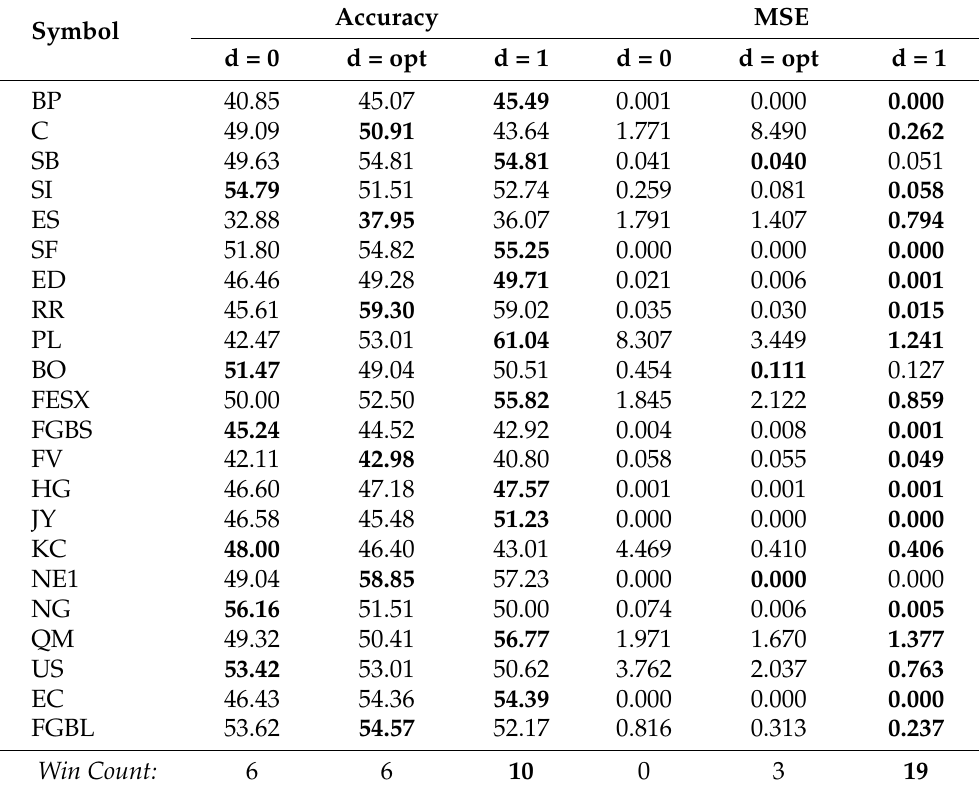
Table 5. Accuracy and MSE results of predicted prices.